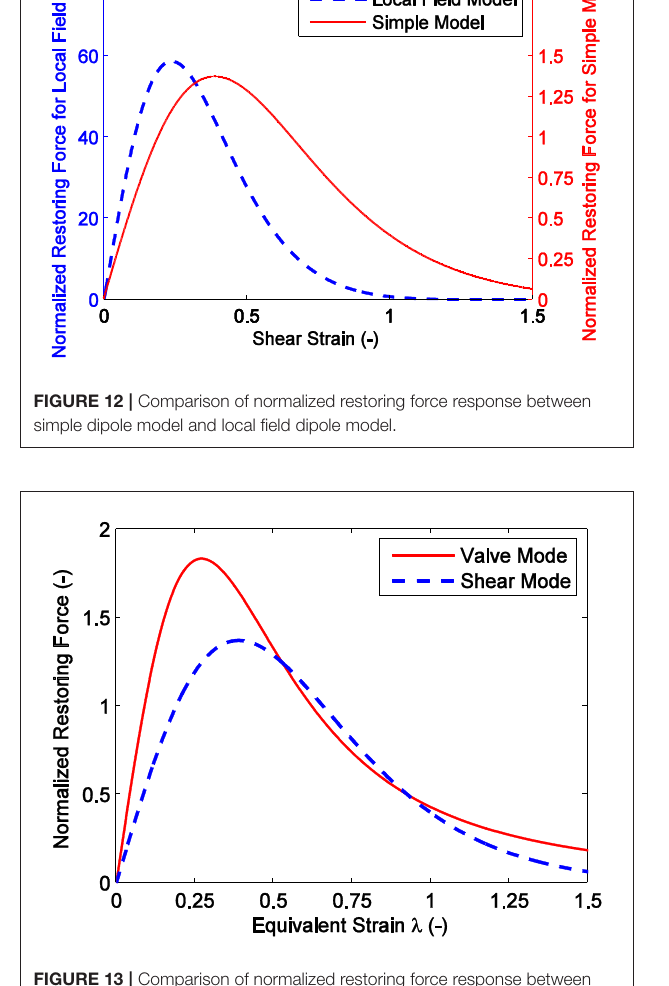
FIGURE 13 | Comparison of normalized restoring force response between shear mode and valve mode (Chen et al.,